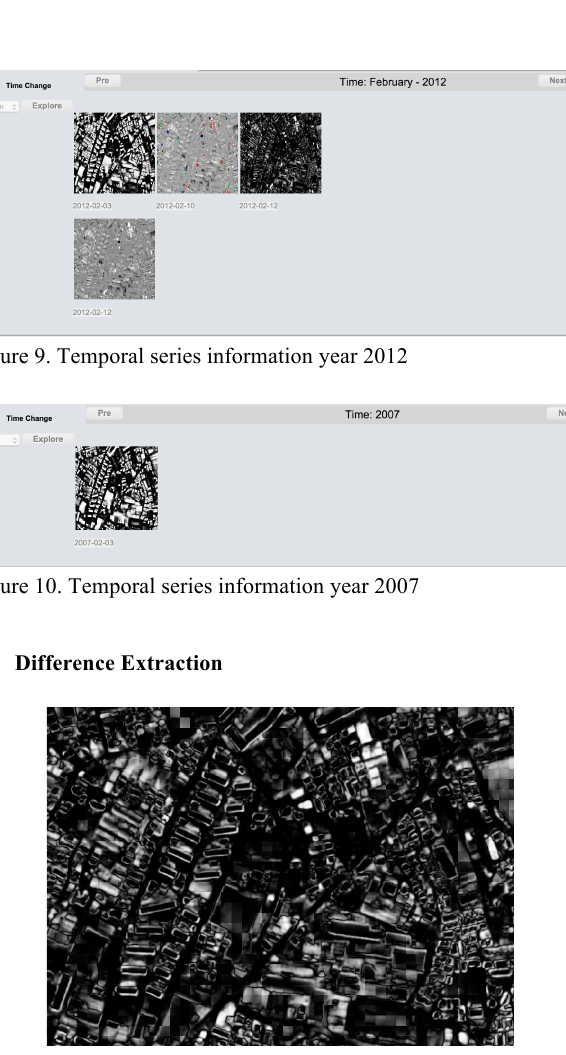
Figure 11. Difference extraction via Euclidean distance method